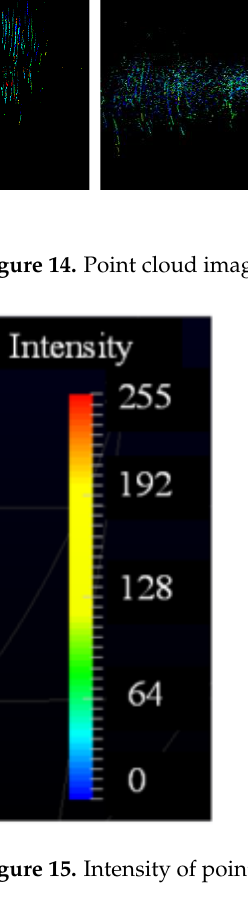
Figure 15. Intensity of point cloud map.